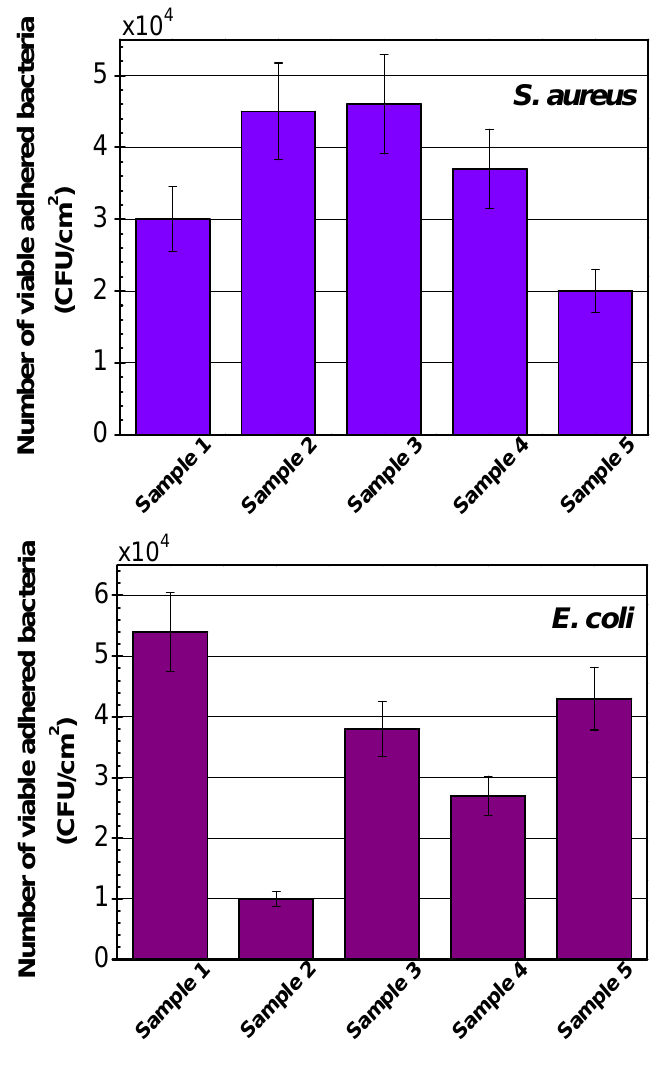
Figure 5. Histograms of bacterial adhesion degree for Samples 1-5 after 24 h incubation against two microorganisms, (error bars depict standard